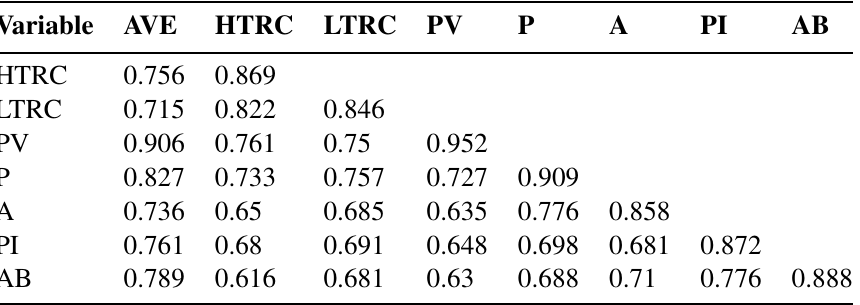
Table 4 Discriminate validity